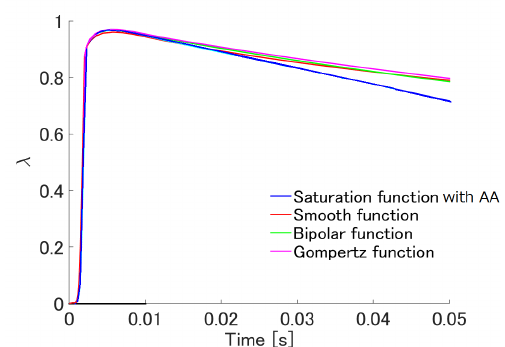
Figure 21. Enlarged view of time response of slip ratio on icy road (( 0 < t < 0 : 05